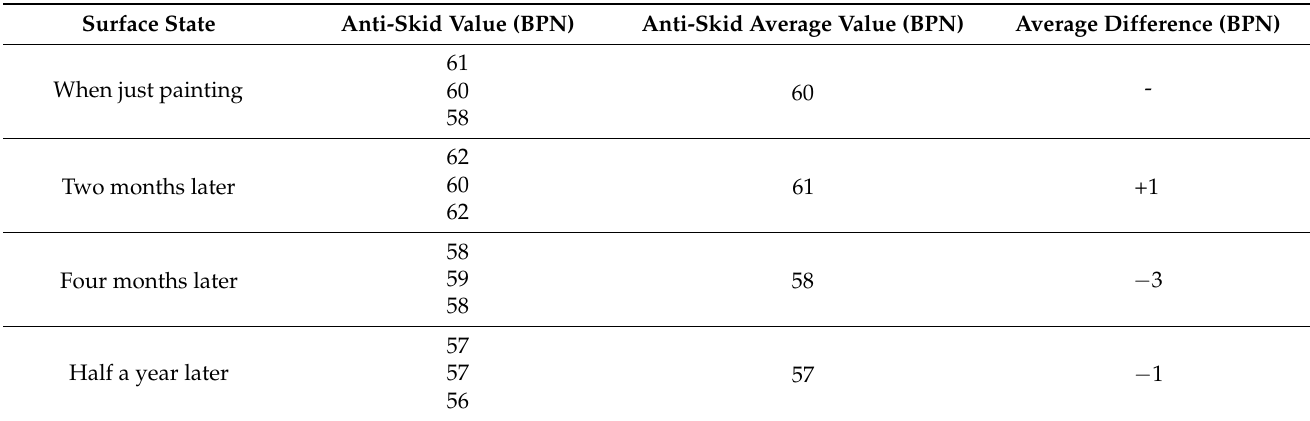
Table 13. Comparison of anti-skid pendulum value.